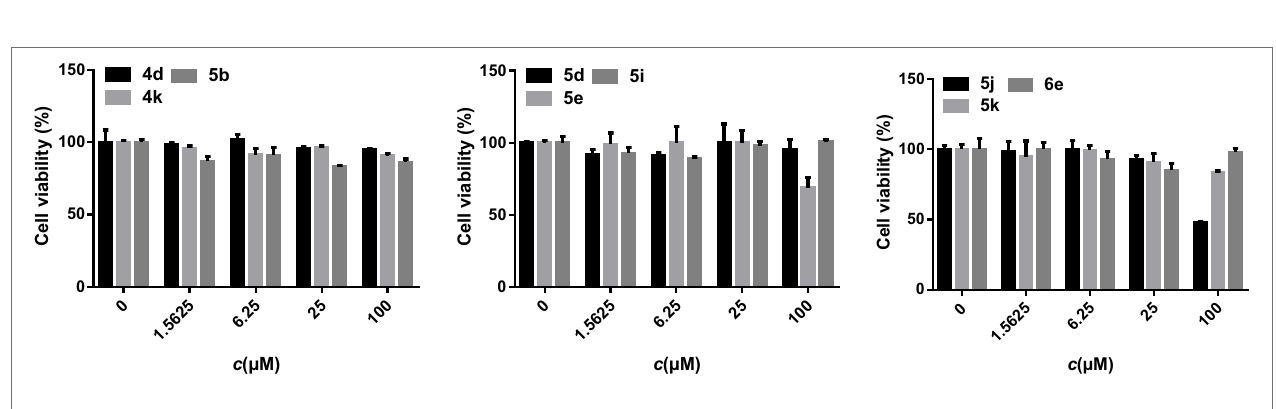
FIGURE 3 | Cytotoxic activity results of target